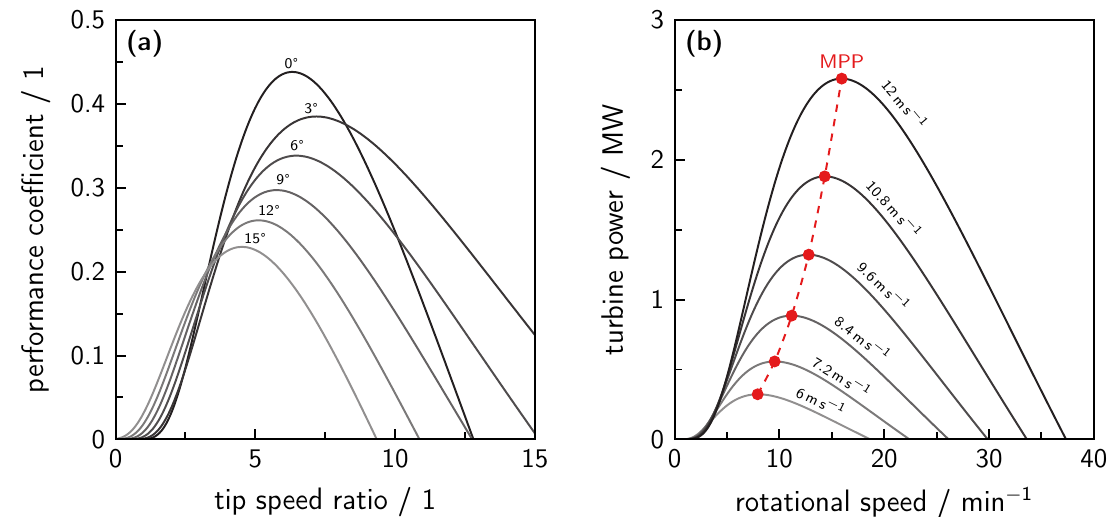
Figure 11. Example calculation results of ( a ) the performance coefficient for various rotor blade pitch angles using Equation (17) and ( b ) the wind turbine power for different wind velocities using Equation (16). The maximum power point (MPP) trajectory is marked